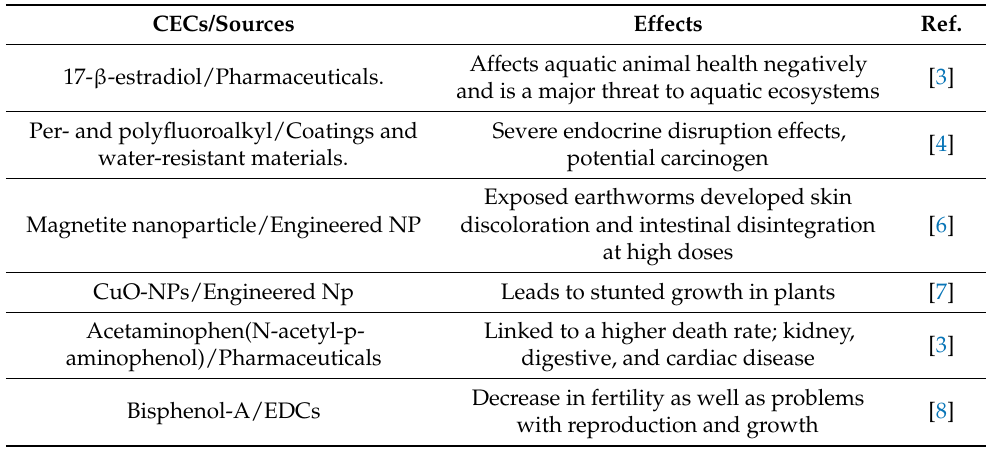
Table 1. CECs present in the ecosystem, their sources, and effects on the